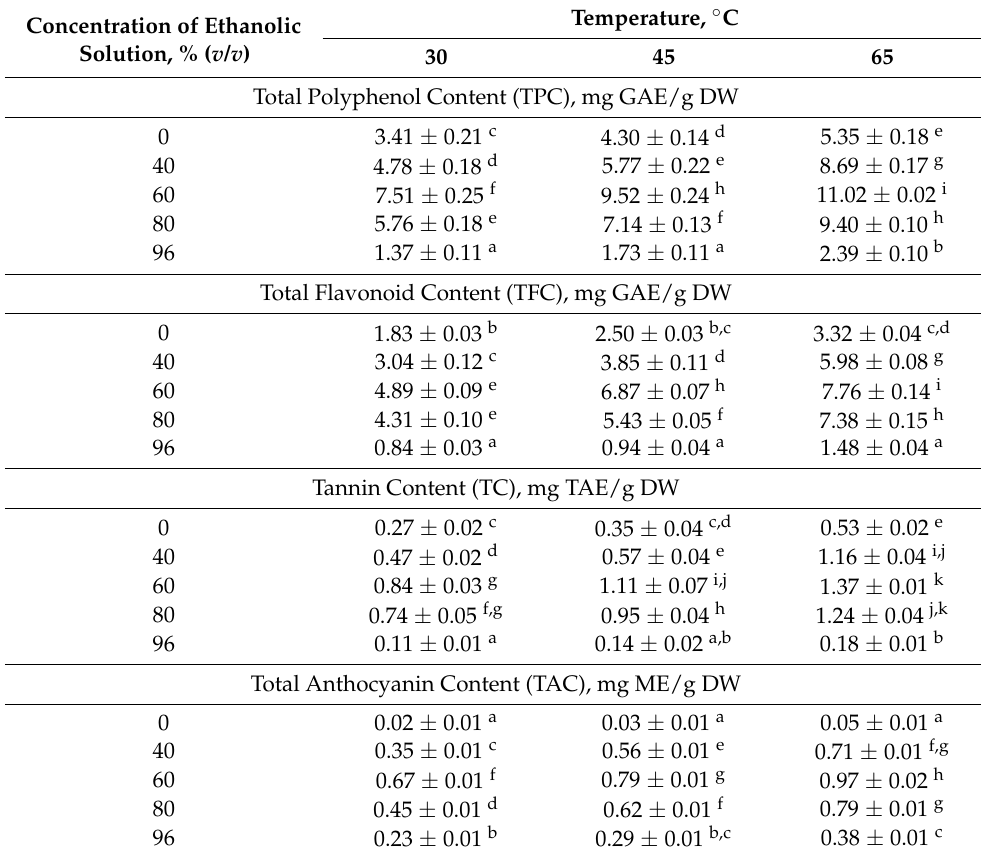
Table 1. Influence of temperature on the extraction yield of the TPC, TPF, TC and TAC in GME depending on the concentration of ethanolic solutions (the results are expressed as means ± standard deviations of three